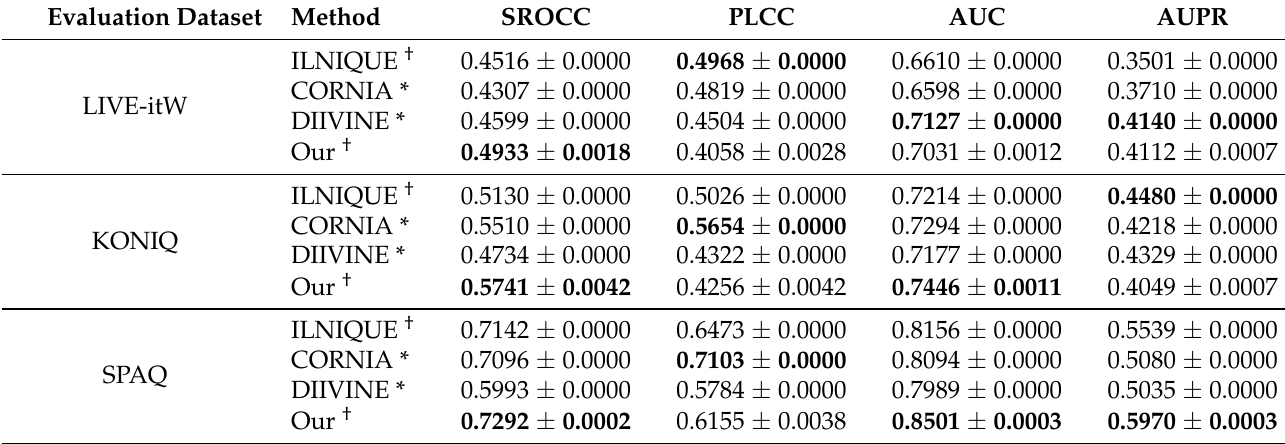
Table 4. SROCC, PLCC, AUC, and AUPR of the proposed solution respect the three from state of the art methods (ILNIQUE, CORNIA, DIIVINE) for each datasets taken into account (LIVE-itW, KONIQ, and SPAQ). For each database, in each column, the best values are marked in